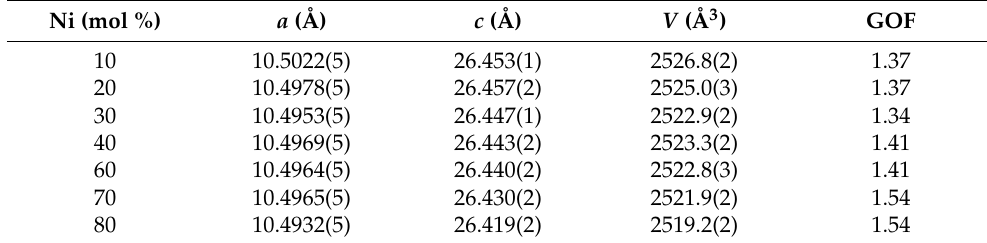
Table 5. Le Bail refinements for co-precipitations of [Ni(bpy) 3 ](PF 6 ) 2 with [Zn(bpy) 3 ](PF 6 ) 2 a .